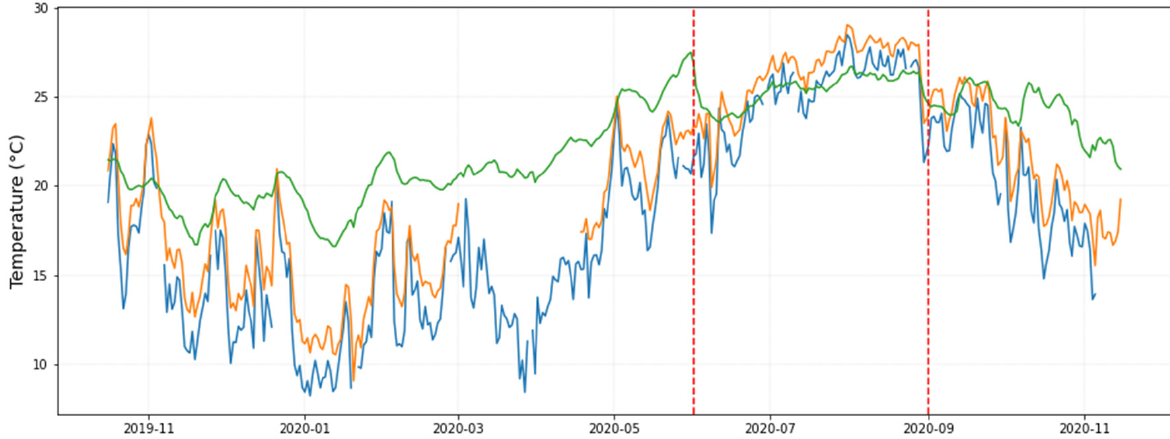
Figure 8. Evolution over time of daily-mean temperatures: (i) average from all sensors located inside the museum (in green), (ii) from a nearby weather station at 2 km away (in blue), and (iii) from the data-logger installed outside (in orange; part of this trajectory is missing, mainly from March to April 2020). The two vertical dashed lines indicate a period when the indoor temperature suddenly drops lower than the outdoor temperature.